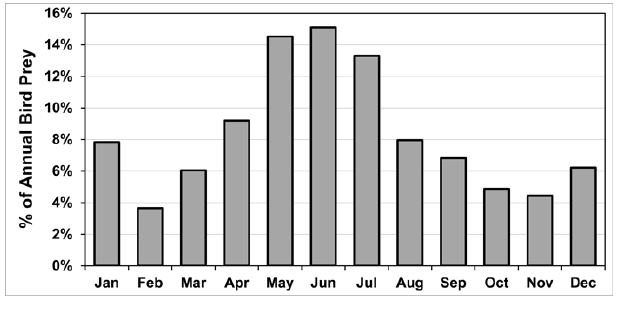
Fig. 1 . Seasonal distribution of bird returns by pet cats, averaged across five year-round temperate-zone studies (Churcher and Lawton 1987, Barratt 1997, Flux 2007, van Heezik et al. 2010; C. Fiore and K. B. Sullivan, unpublished manuscript ). Data from the southern hemisphere were offset by six